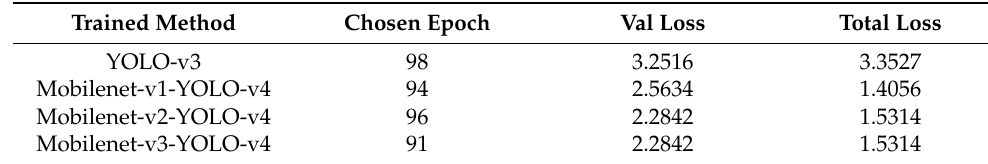
Figure 13. Training structure of the improved YOLO-v4. Table 6. The employed weight file during detection.